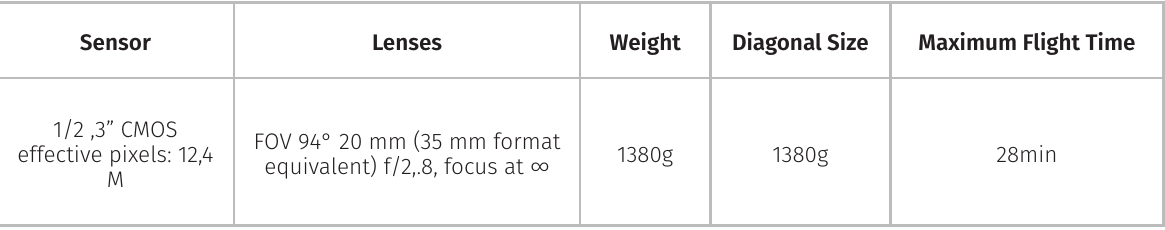
Table I. Main particularities of UAV Phantom 4 (DJI